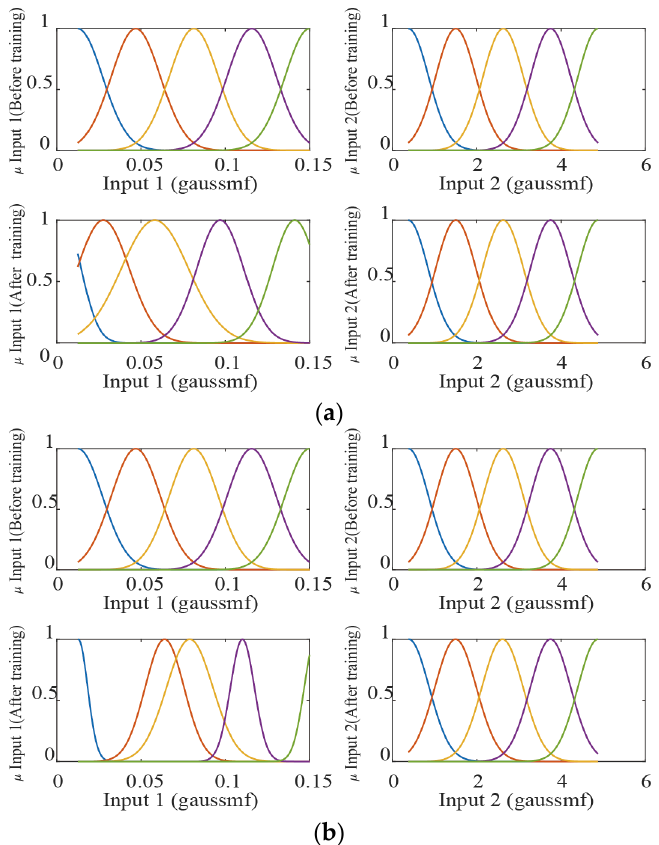
Figure 8. Comparison of affiliation functions before and after training of K I and K P ( a ) The affiliation function of free volume before training; ( b ) The affiliation function of pressure after training.